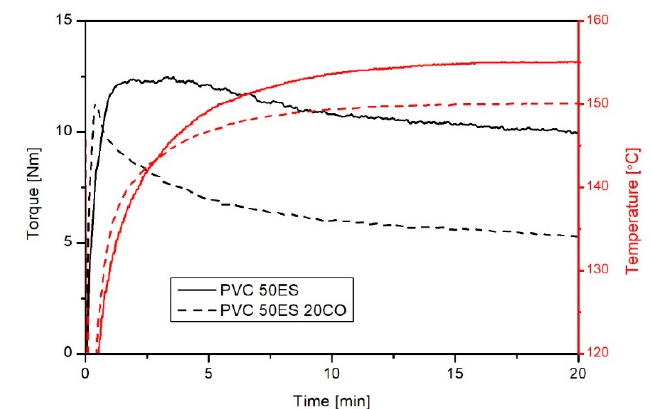
Figure 1. An exemplary plastogram of PVC 50ES and PVC 50ES 20CO.